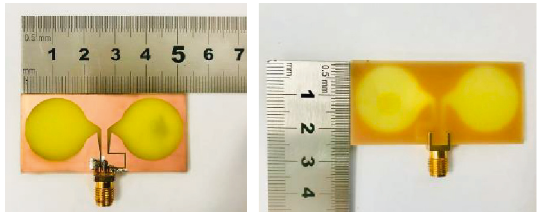
Figure 13: Fabricated structure of the proposed antenna.